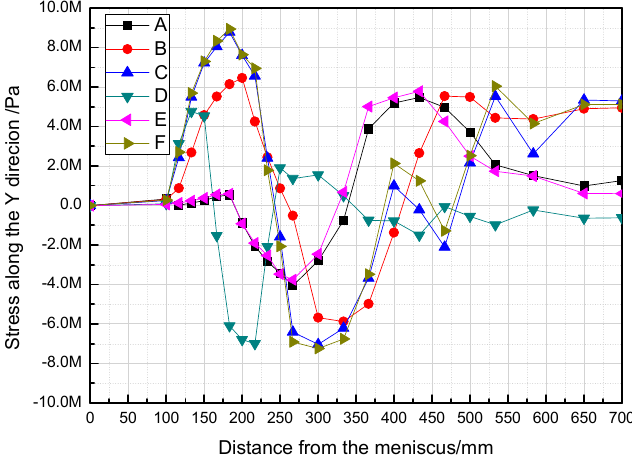
Figure 11. Stress along Y direction with distance at some typical points.